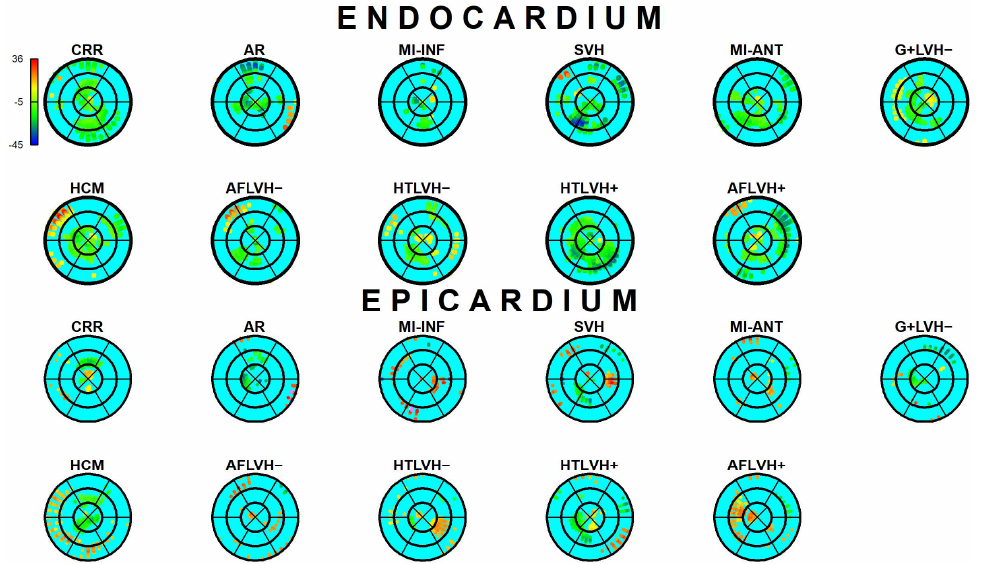
Figure 9. Differences ∆ kCNT − ∆ kother between α p values of control group and other categories. Landmarks with no significant differences are colored in cyan. Abbreviations: Cirrhosis (CRR), Aortic regurgitation (AR), Myocardial infarction of inferior wall (MI-INF), Myocardial infarction of anterior wall (MI-ANT), Mutation carriers for hypertrophic cardiomyopathy with LV hypertrophy (HCM), Secondary ventricular hypertrophy (SVH), Mutation carriers for hypertrophic cardiomyopathy without LV hypertrophy (G+LVH − ), Atrial fibrillation without ventricular hypertrophy (AFLVH − ), Atrial fibrillation with ventricular hypertrophy (AFLVH+), Hypertension without LV hypertrophy (HTLVH − ), and Hypertension with LV hypertrophy (HTLVH+).